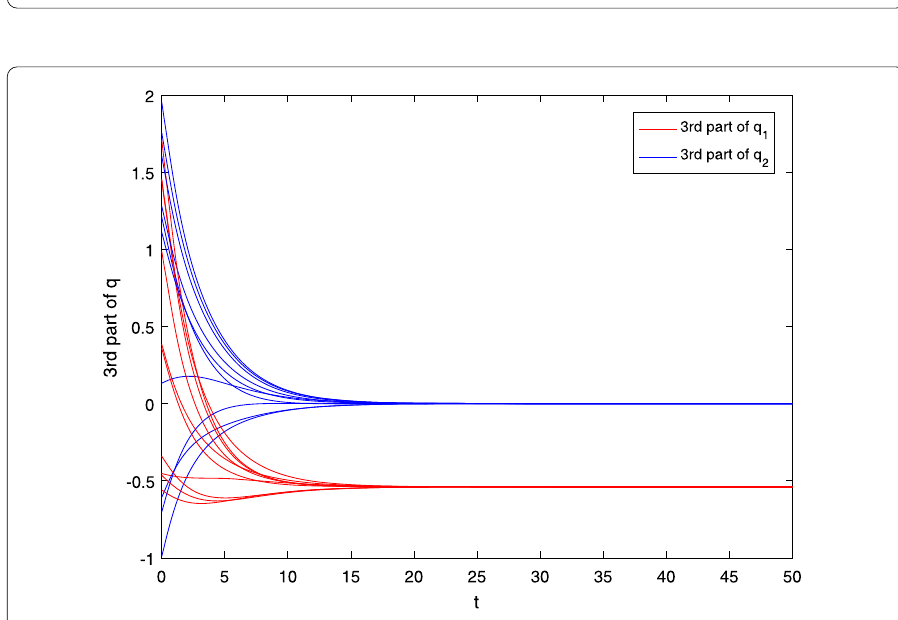
Figure 3 The third part of the state trajectories for system (1) with parameters